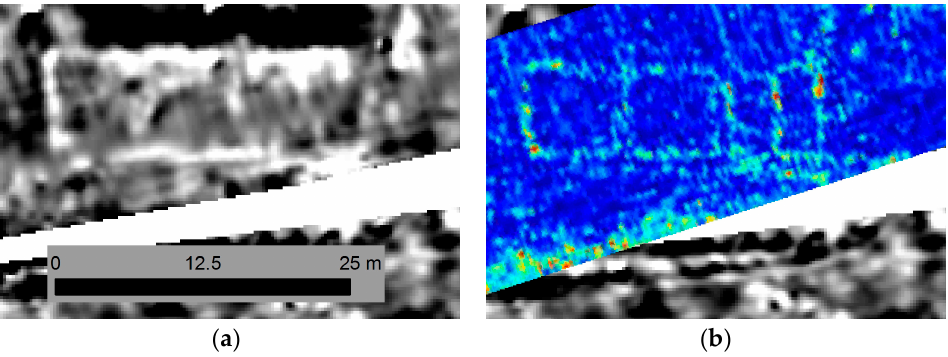
Figure 12. Magnetometers are the work-horses of archaeological prospection. However, it is the best practice to integrate other sensors into the work schema. ( a ) Geomagnetic data from Magoula Almyriotiki reveals a large building to the south of the settlement. ( b ) GPR survey in the same area further corrects this argument and suggests three buildings; two rectangular buildings to the west and another one, equally partitioned, to the east.